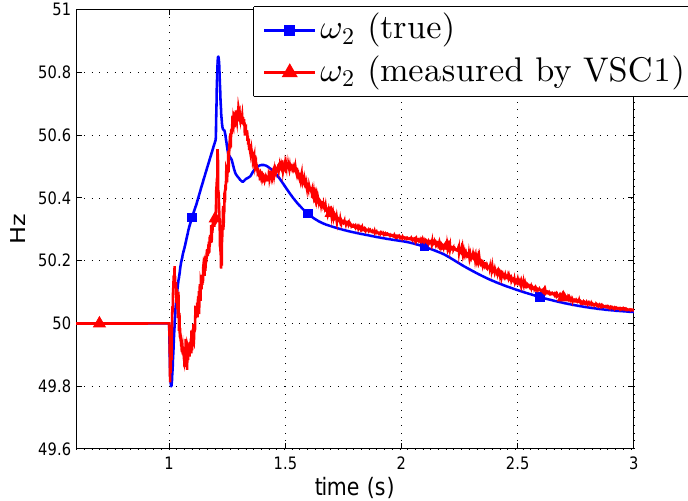
Figure 20. Case D. Strategy P-WAF with τ ij = 100 ± 20 ms (triangular distribution). Frequency of VSC2 measured by